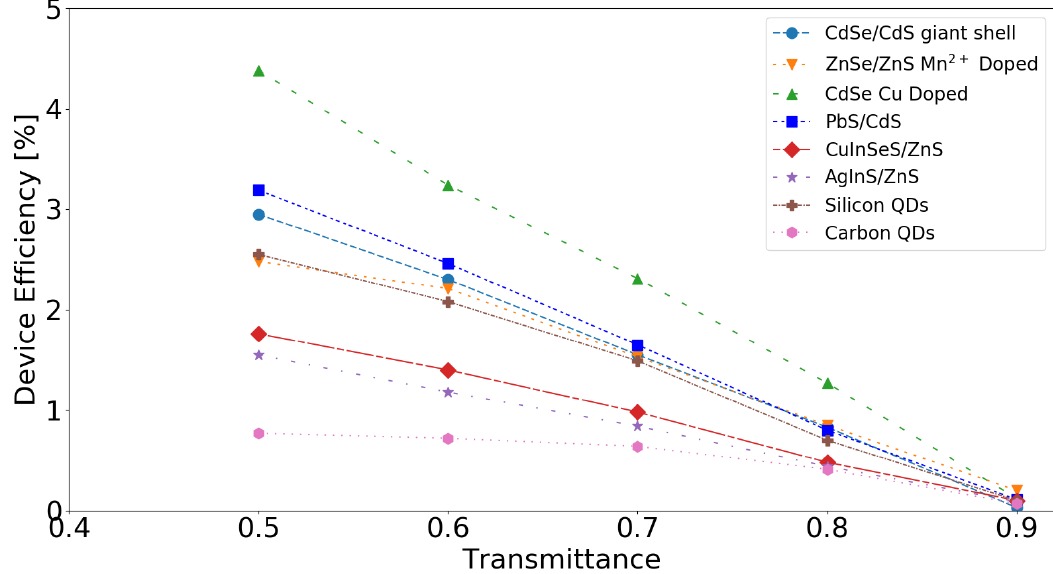
Figure 14. Percentage of device efficiency, plotted against T vis